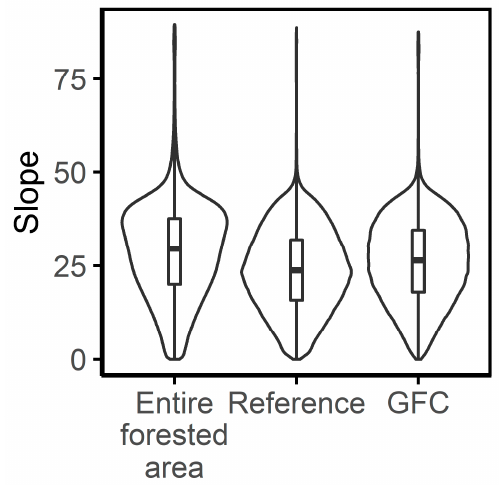
Figure 6. Comparison of violin and box plots of the distribution of slope for the entire forested part of the study area with the distributions for areas of forest loss during 2014 to 2016 derived from the reference and GFC datasets.